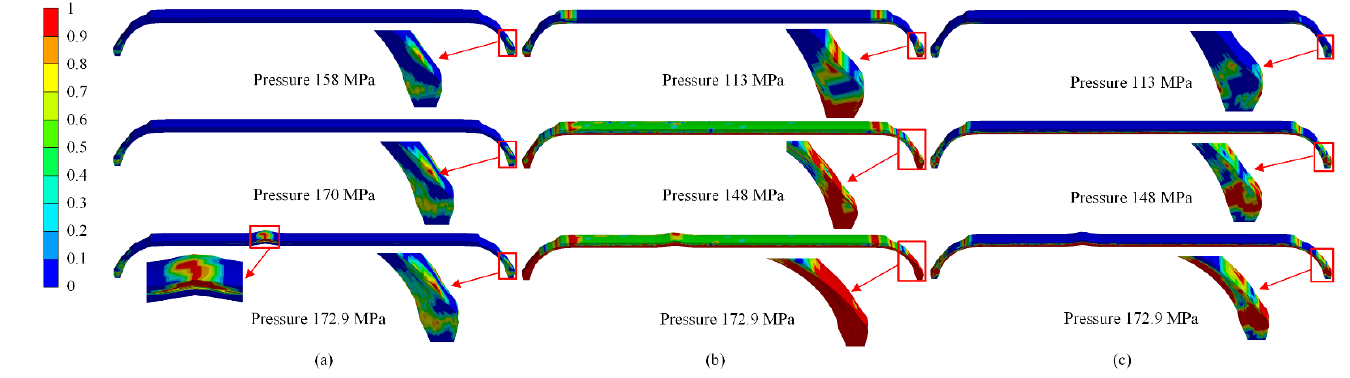
Figure 16. Numerical results of progressive damage of the composite layers in the composite hydrogen storage vessels: ( a ) fiber tensile, ( b ) matrix tensile, and ( c ) matrix compression.